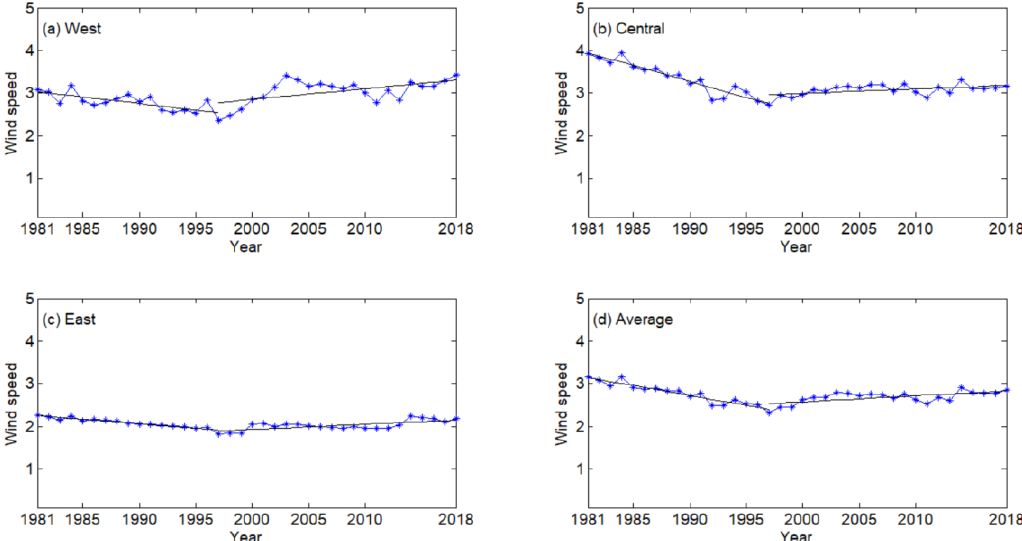
Figure 8. Variations in annual mean wind speed (m/s) derived from CMFD reanalysis data for the western ( a ), central ( b ), eastern ( c ), and entire TP ( d ) during the period 1981 – 2018. All of the trends are derived from linear least − squares regressions and are significant at the 95% confidence level using the Mann – Kendall trend test.